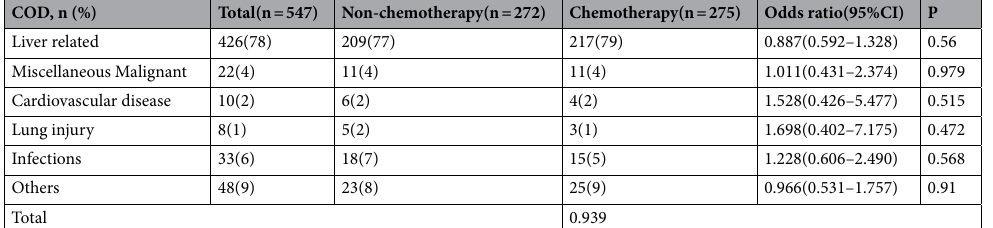
Table 5. Comparision of causes of death in HCC patients with chemotherapy and without chemotherapy. *Two-sided P values < 0.05. **Two-sided P values < 0.01. ***Two-sided P values < 0.001. COD, cause of